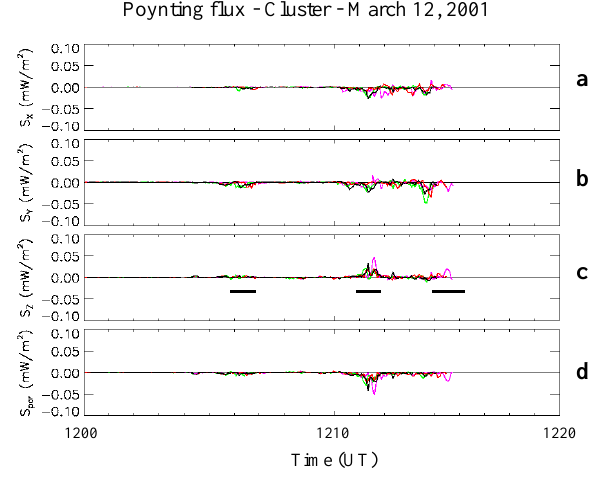
Fig. 14. (a)–(c) The GSM components of the wave Poynting flux overlaid from all four Cluster spacecraft for the interval between 12:00 and 12:20UT. (d) The parallel Poynting flux overlaid for each of the spacecraft (1 – black; 2 – red; 3 – green; 4 –